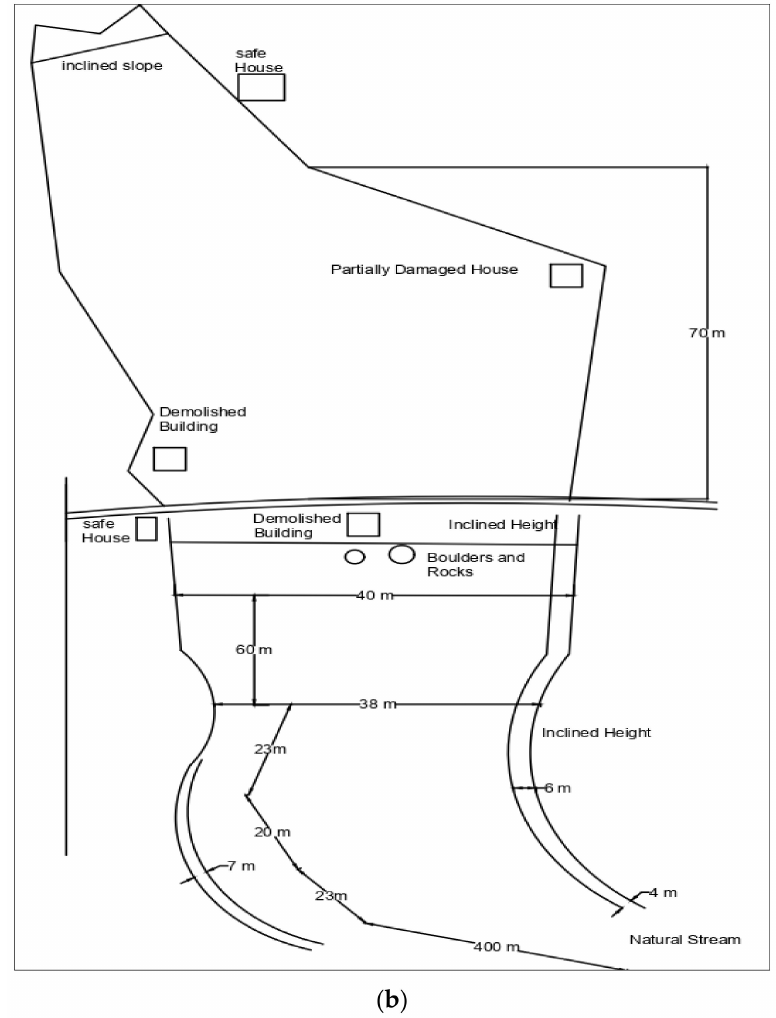
Figure 5. Sketch view of ( a ) longitudinal section and ( b ) plan of slope